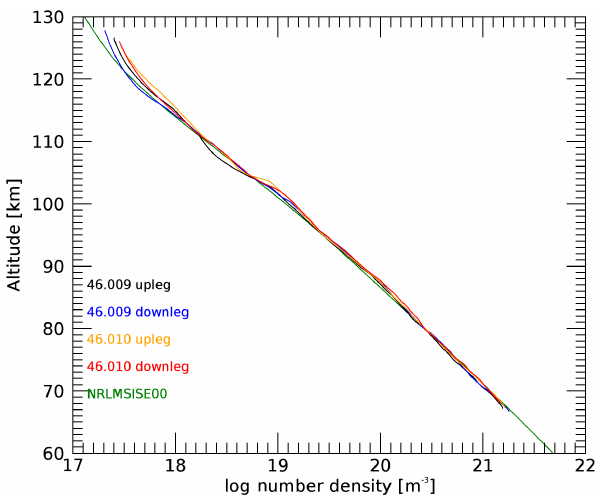
Figure 4. Neutral number densities for four profiles after calibration and ram correction. The four profiles agree now for all altitudes, but display significant variability above